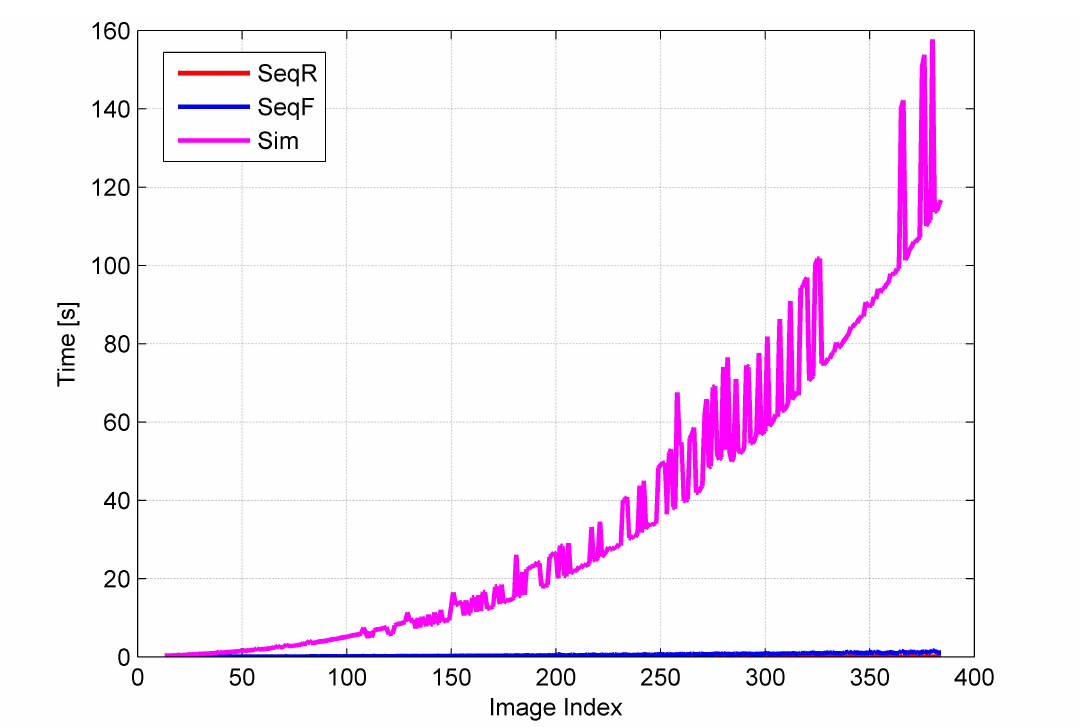
Figure 8. Processing time of the three AT